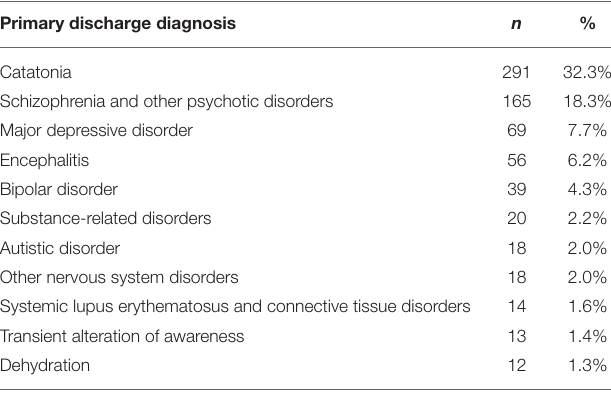
TABLE 2 | Primary diagnostic categories for hospitalizations involving